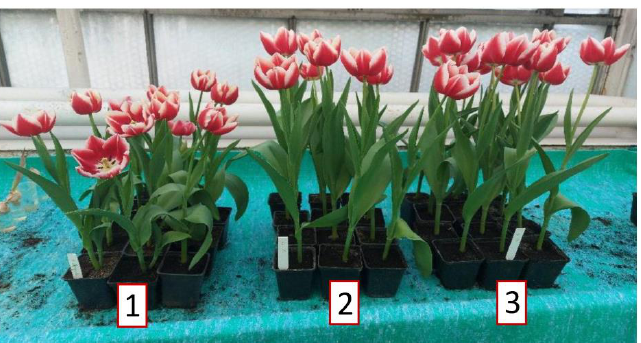
Figure 2. The effect of treatment with BTHWA on the stimulation of tulip height and vigor. (1) UTC; (2) plants treated with BTHWA 20 mg/L; (3) plants treated with BTHWA 40